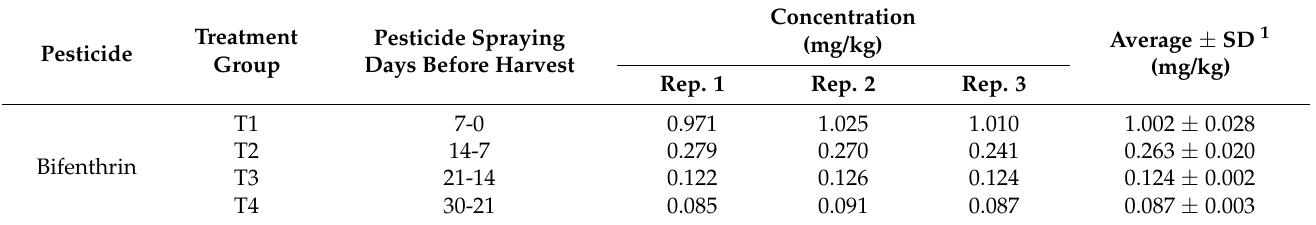
Table 6. The residual results of the active ingredient for the bifenthrin 1 EC in chives.